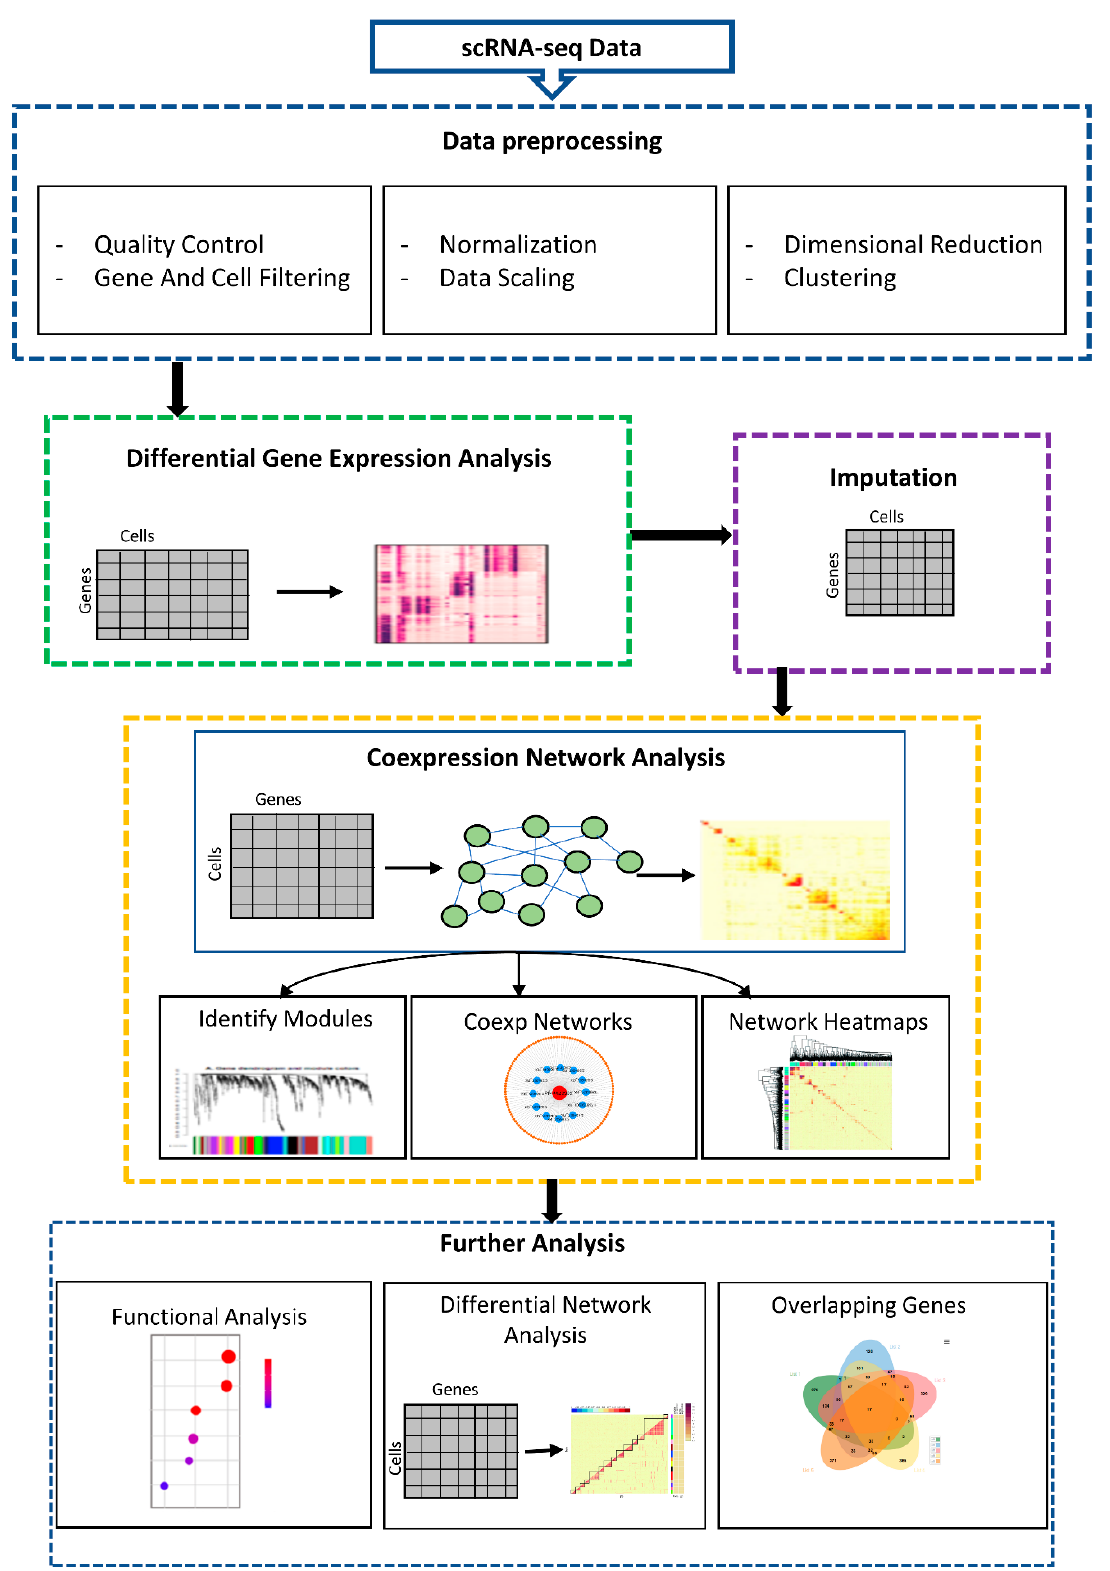
Figure 1. Flowchart of scGENA pipeline.